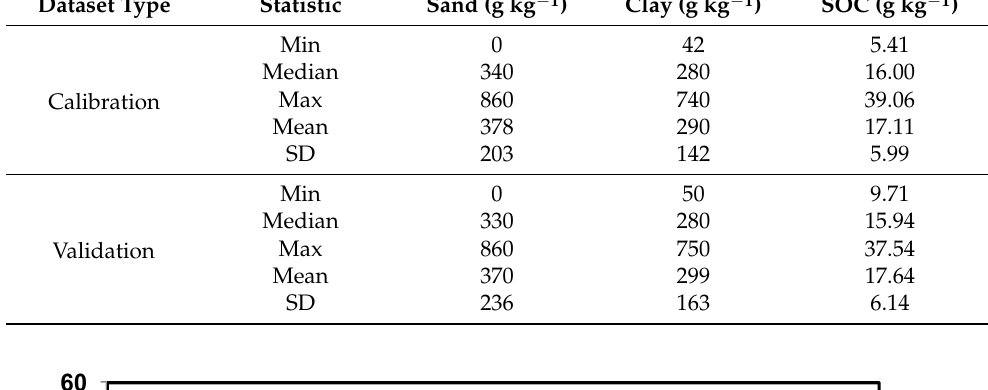
Table 4. Statistical results of PLSR with leave-one-out cross-validation trained on vis-NIR calibra- Table 2. Statistical data of soil properties (analyzed using conventional laboratory methods) observed tion dataset examples and tested on vis-NIR validation dataset examples. in both the calibration and validation sets.